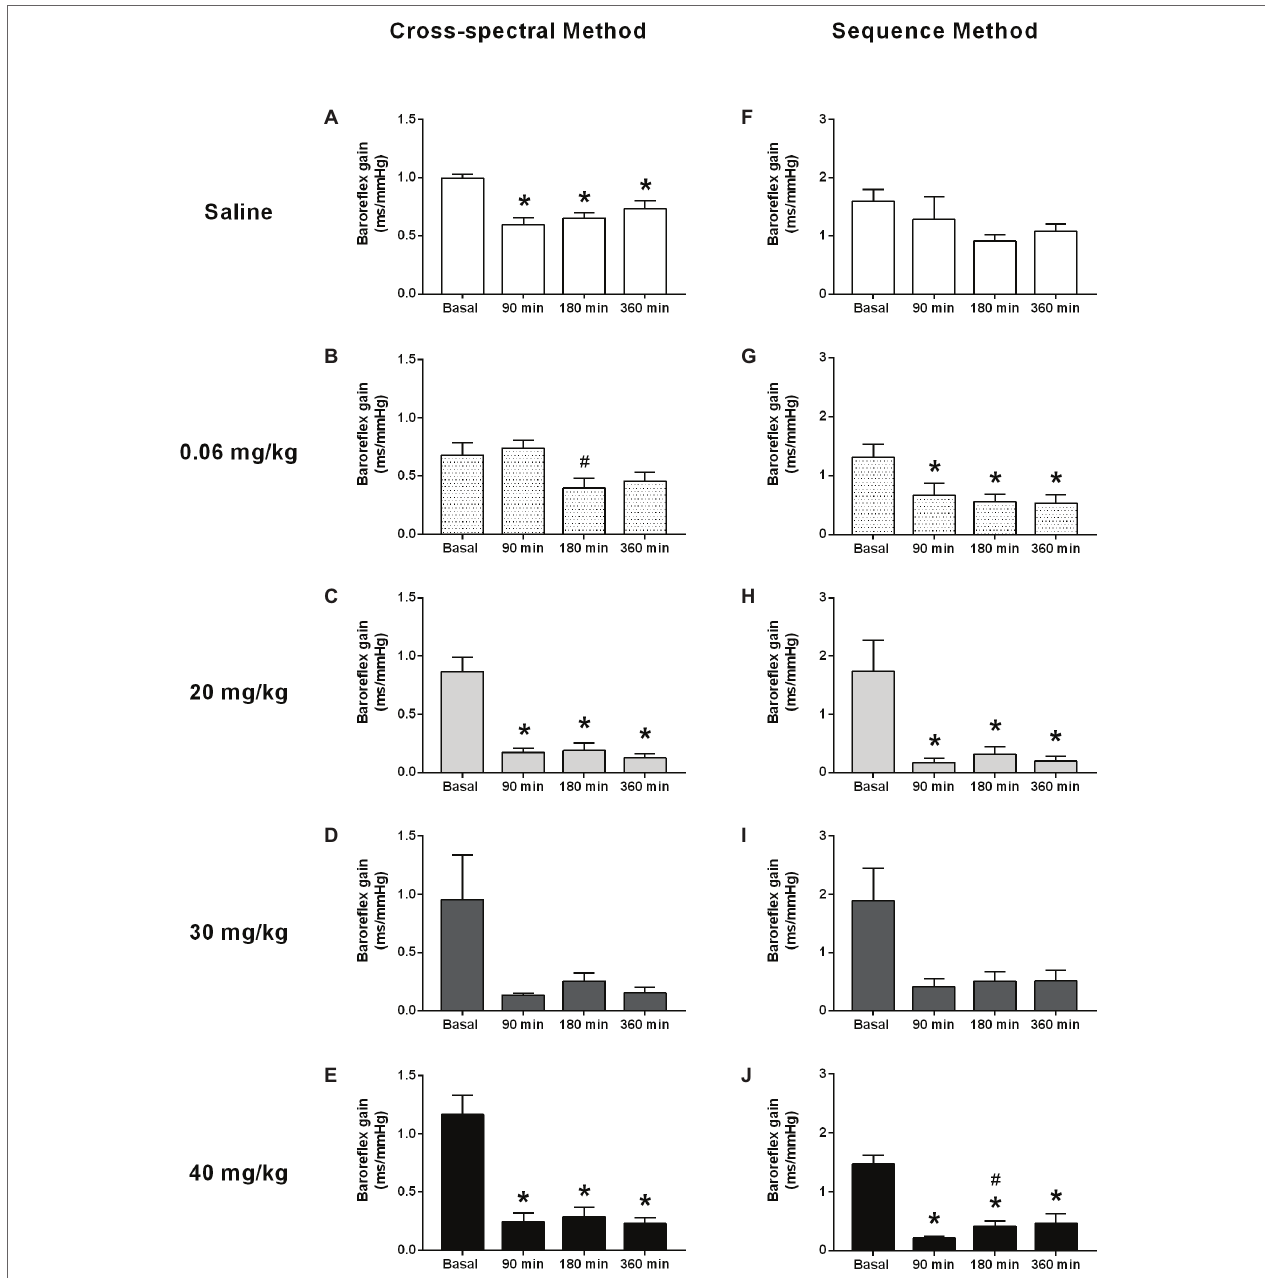
FIGURE 3 | Effects of different doses of lipopolysaccharide in the baroreflex sensitivity in unanesthetized rats. Baroreflex sensitivity analysis by cross-spectral (panels (A–E) ) and the sequence method (panels (F–J) ), after saline or LPS administration. Saline: panels (A,F) ; 0.06 mg/kg of LPS: panels (B,G) ; 20 mg/kg of LPS: panels (C,H) ; 30 mg/kg of LPS: panels (D,I) ; 40 mg/kg of LPS: panels (E,J) . Data are expressed as mean ± standard error of the mean. * p < 0.05 vs. baseline counterpart; # p < 0.05 vs. 90 min